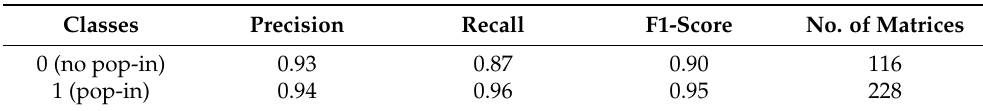
Table 3. Summary of the performance of the CNN model in the validation dataset, including the artificial pop-in dataset in the dataset with pop-ins.